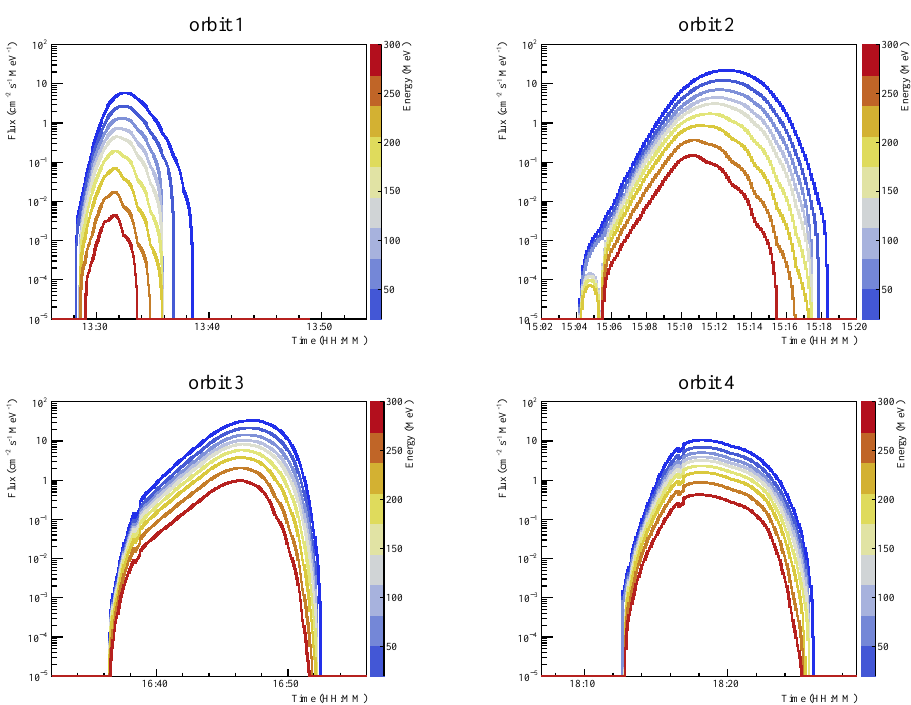
Figure 5. Time profiles (5-s resolution) of 10–300 MeV trapped protons estimated from the AP9 model along CSES orbits 1–4 (from the top left panel to the lower right panel). As expected, higher energies have lower fluxes, while lower energies tend to have higher